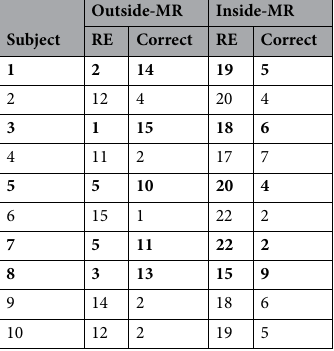
Table 1. RE group’s data obtained from App and fMRI responses. Bolded participants committed reversal errors inside-MR but not outside-MR. There were 16 items to respond to outside-MR and 24 items inside-MR.